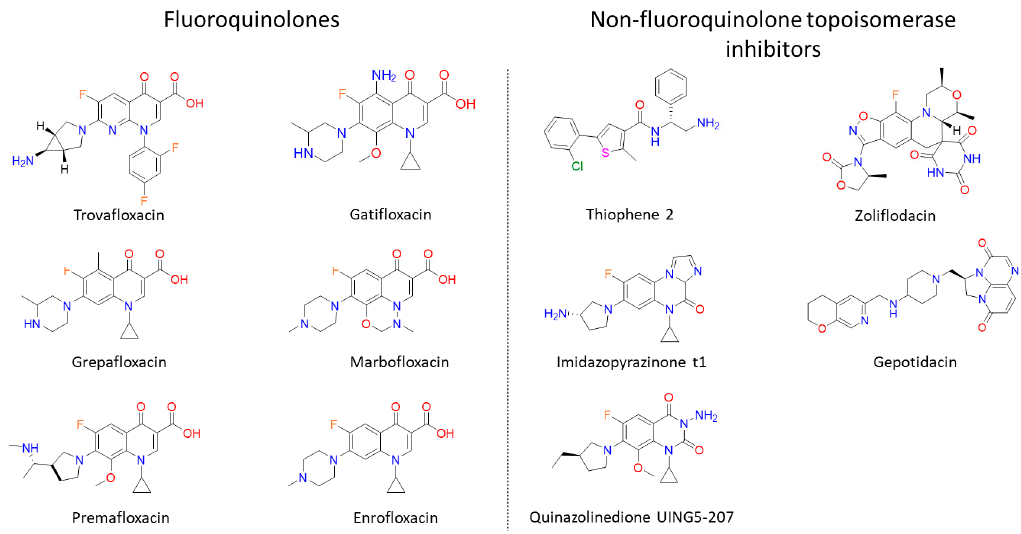
Figure 3. Structures of “new” fluoroquinolones and non-fluoroquinolone topoisomerase inhibitors Structures of “new” fluoroquinolones and non-fluoroquinolone topoisomerase discussed in the text. Gepotidacin and Zoliflodacin (Novel Bacterial Topoisomerase Inhibitors) are inhibitors discussed in the text. Gepotidacin and Zoliflodacin (Novel Bacterial